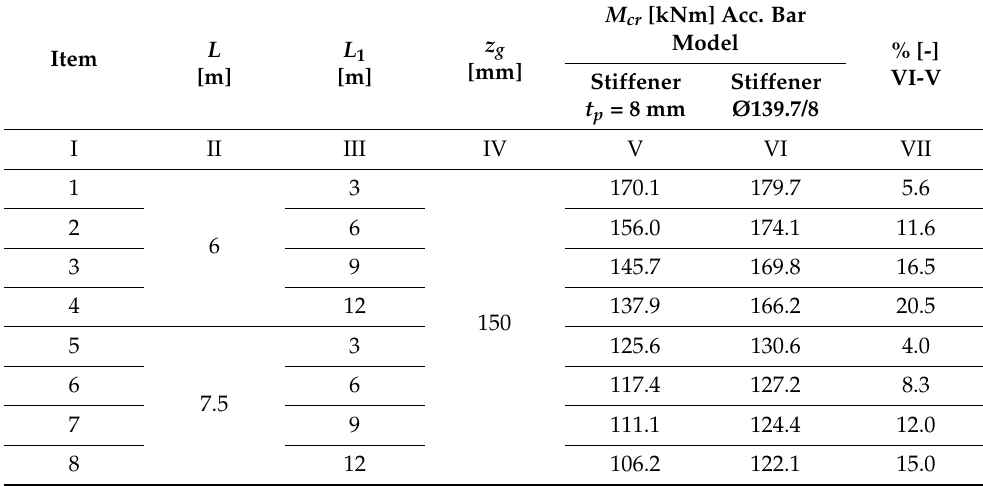
Table 5. Critical moment ( M cr ) of the critical beam B–E of H-shaped grillage, uniformly loaded ( z g = + h /2), from LTBeamN (thin-walled bar